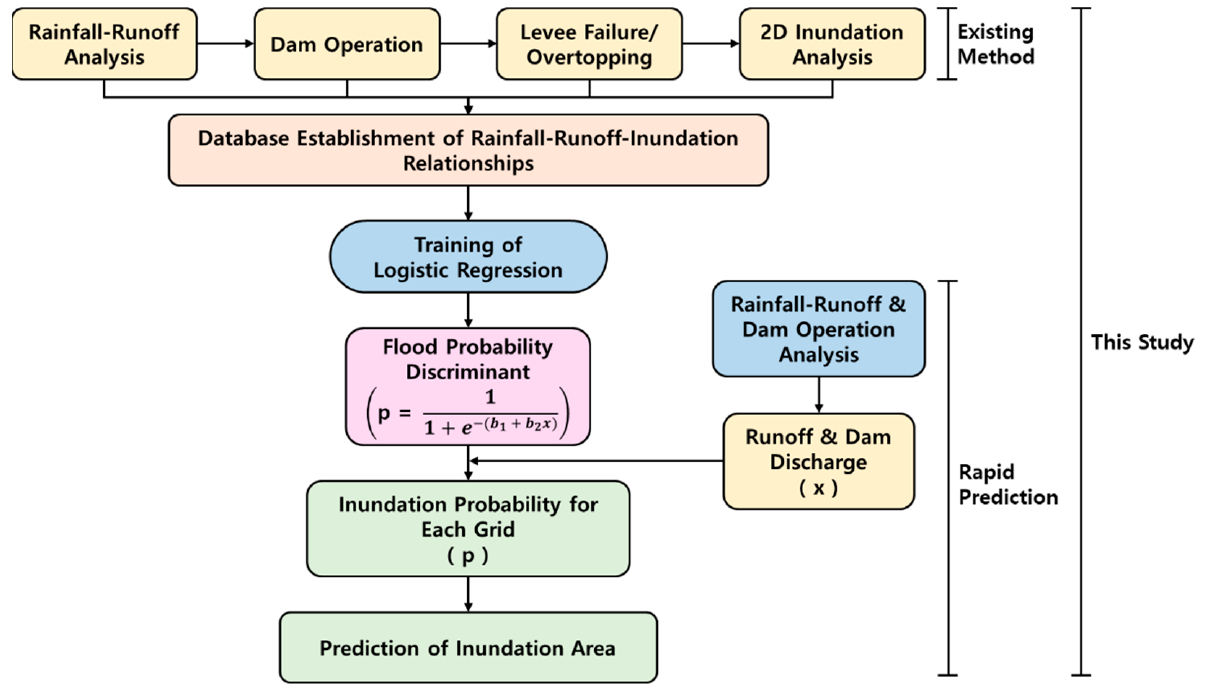
Figure 1. Flow chart of this study.